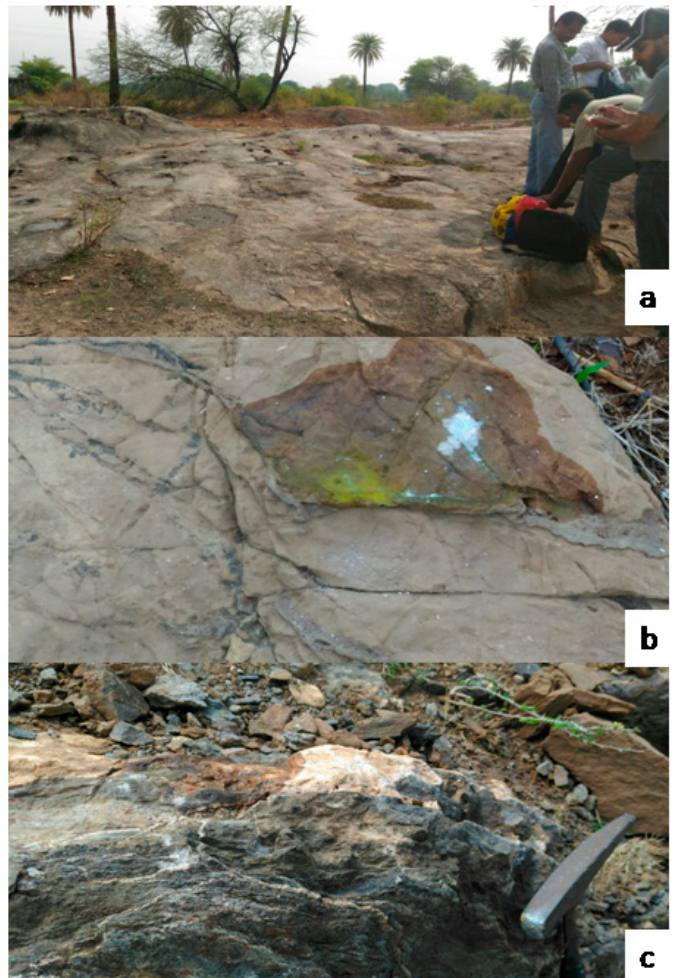
Figure 3. ( a ). Surface exposures of dolomite. ( b ) Surface exposures of low-grade rock phosphate ( c ). Surface exposures of high-grade phosphorite.